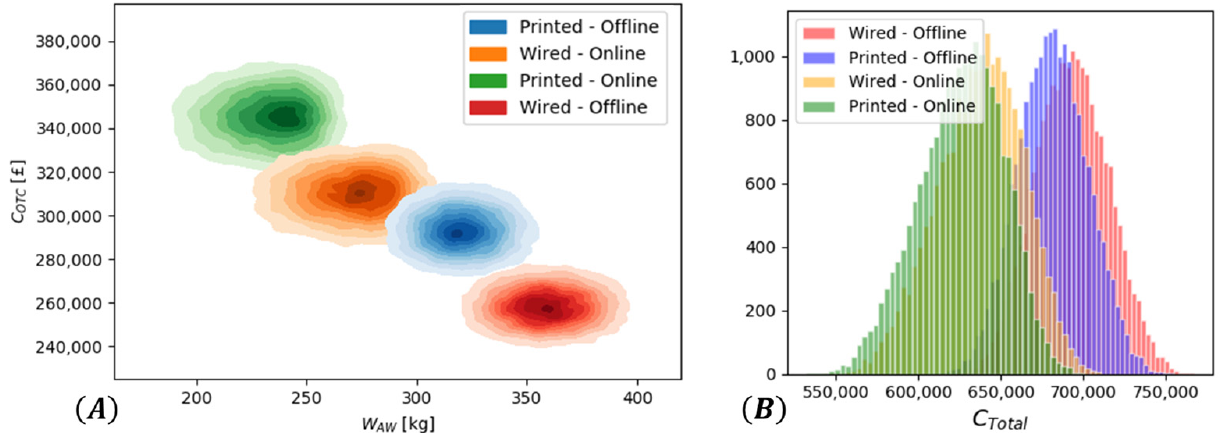
Figure 9. ( A ) Density plots of 𝐶